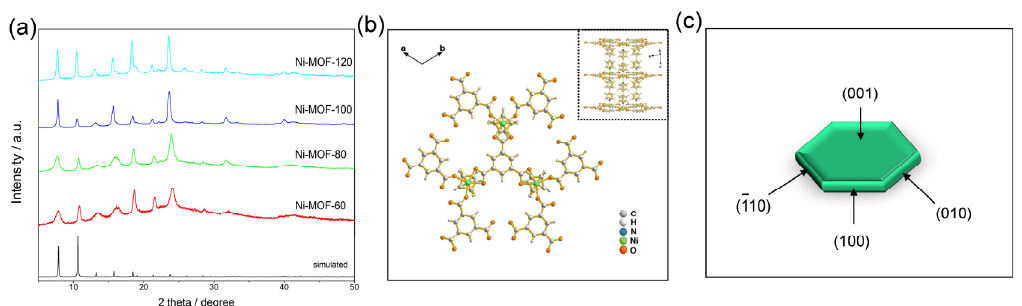
Figure 2. ( a ) X-ray diffraction patterns of Ni-MOF-60, Ni-MOF-80, Ni-MOF-100, and Ni-MOF-120; ( b ) Schematic diagram of Ni-MOF, Ni: green, C: gray, O: orange, and N: blue; ( c ) Diagram of MOF single-crystal figure.